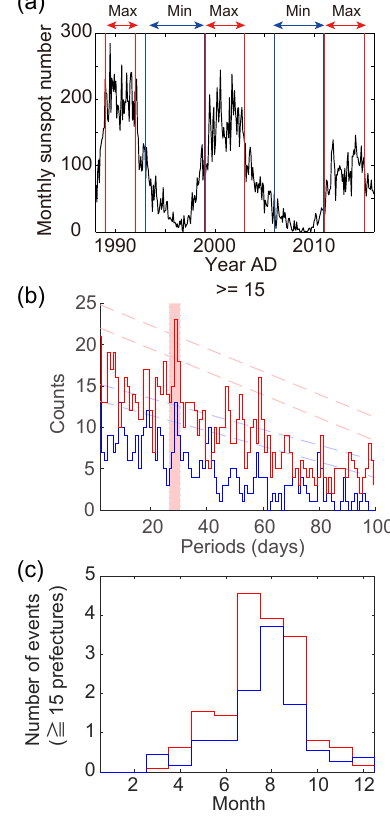
Figure 4. (a) Time series of monthly sunspot numbers for AD1989–2015. The red and blue arrows define the periods of solar maxima and minima used for the analyses. (b) Same as Fig. 2 but only for the events covering more than 15 prefectures. Data were an- alyzed for solar maxima (red line) and minima (blue line), indepen- dently. The 1-day time lag in the Ky¯ush¯u area is considered, as for Fig. 3. Red dashed lines denote the 2 and 3 standard deviations for solar maxima; blue dashed lines are for solar minima. (c) Monthly average number of wide-area lightning activity instances covering more than 15 prefectures at solar maxima (red line) and minima (blue